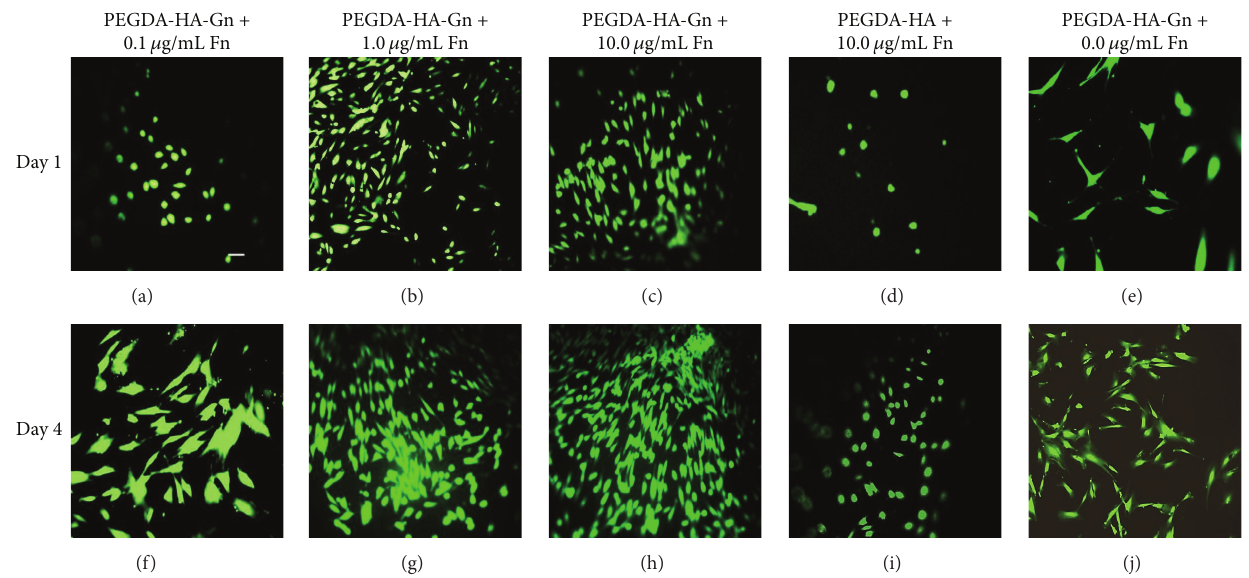
Figure 5: (a–j) Immunofluorescence staining results of human dental pulp stem cells seeded on the surface of polyethylene glycol diacrylate- basedhydrogels.Datarepresentsasampleofarandomfieldofviewfrom4randomfieldsofviewperhydrogel.Green=livecells.Magnification = 20x. Scale bar = 50 𝜇 m.